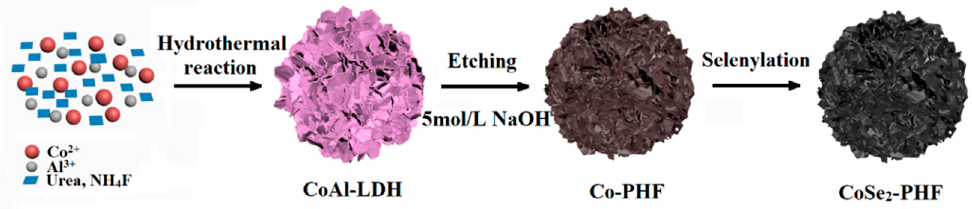
Figure 1. Schematic of synthesis process for CoSe 2 ‐ PHF.